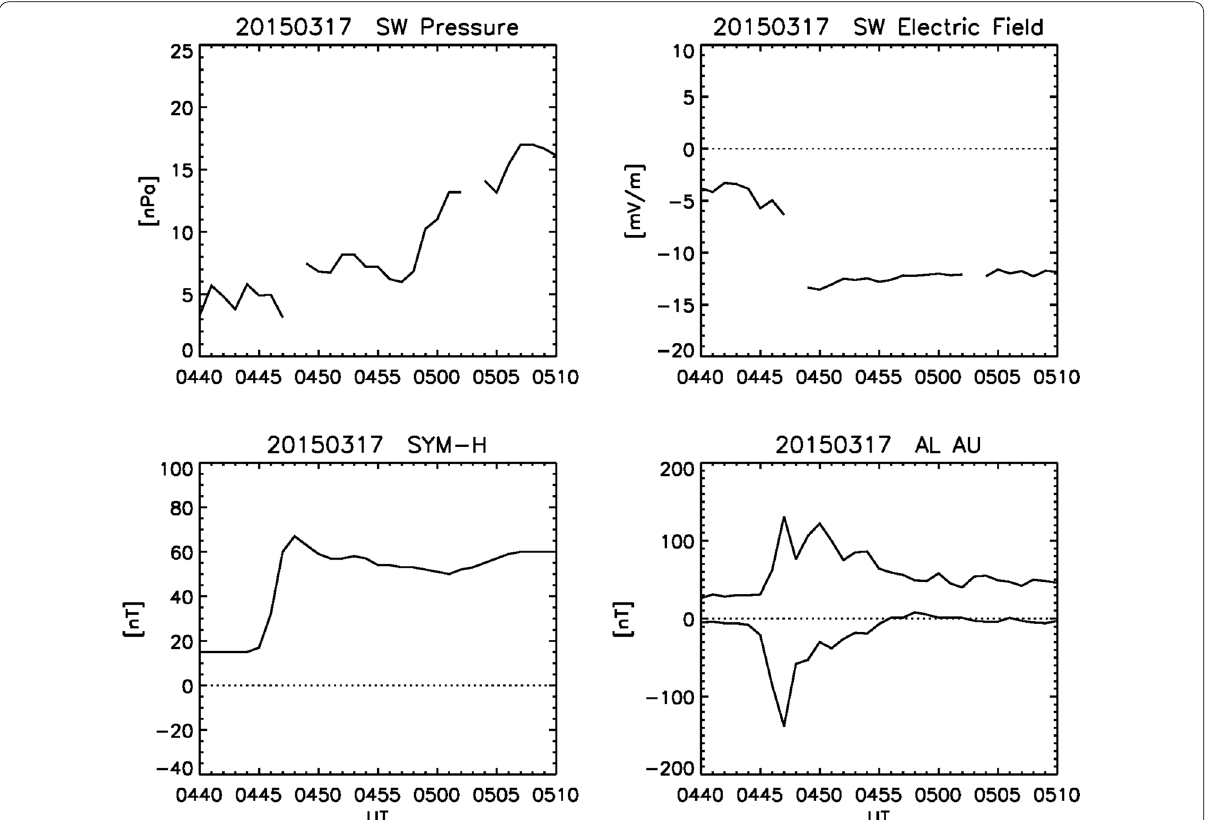
Fig. 1 Solar wind flow pressure (top left) and electric field (top right) at the magnetopause (from the OMNI provided by NASA), and geomagnetic SYM-H (bottom left), AL and AU (bottom right) indices as derived from the ground magnetometer data (from WDC for Geomagnetism, Kyoto) during the geomagnetic sudden commencement on 17 March,